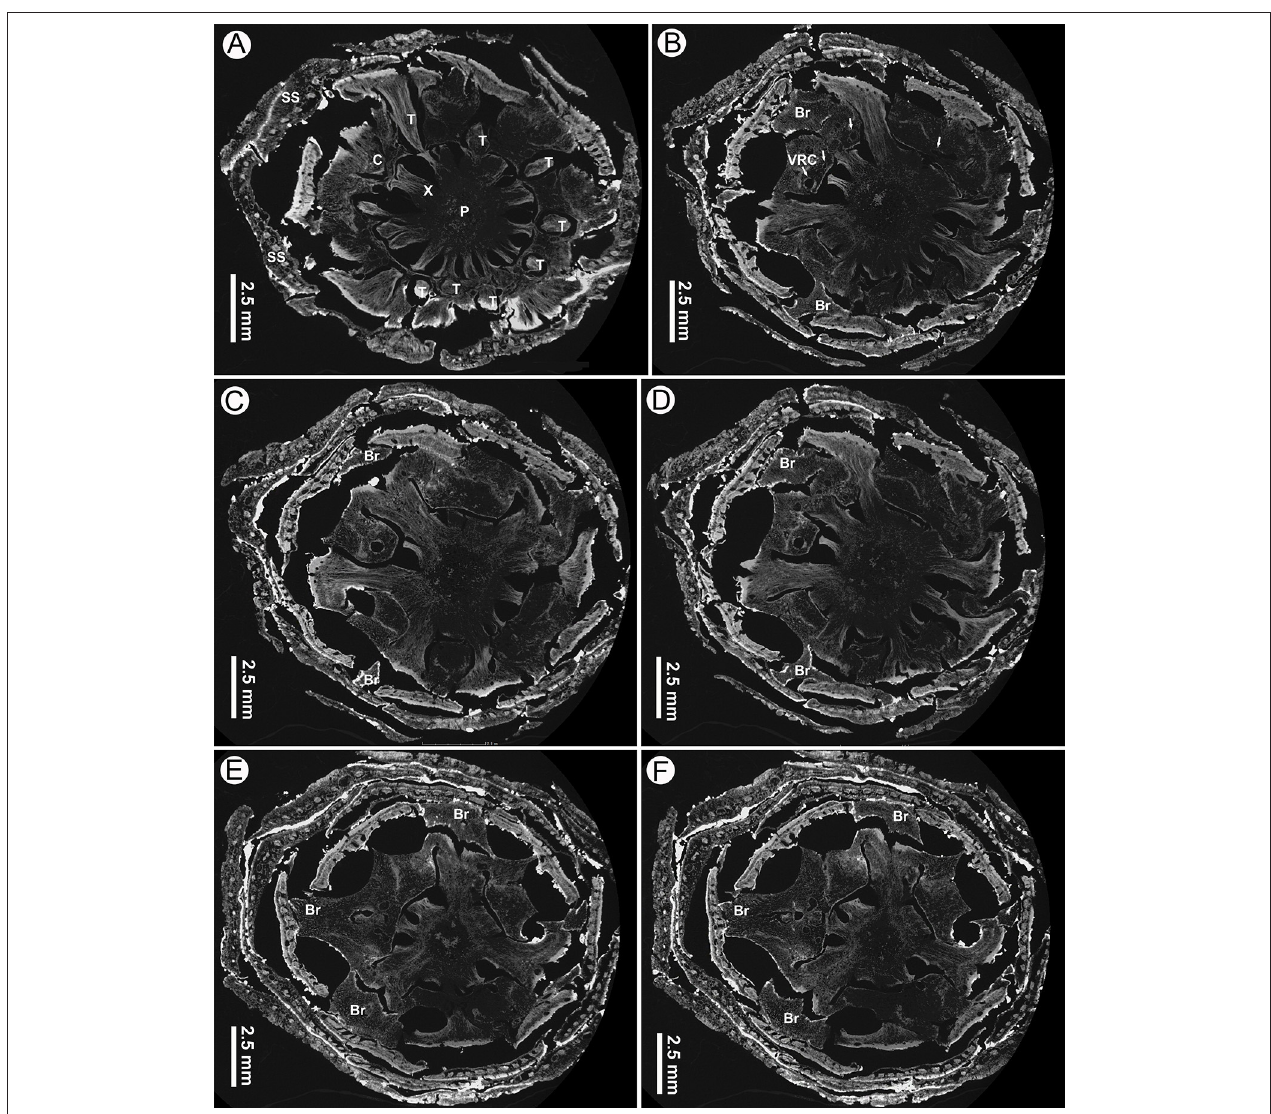
FIGURE 8 | Virtual transverse sections of a seed cone of Pinus prehwangshanensis sp. nov., holotype, specimen MMRH170, micro-CT. (A) Traces of bract-scale vascular complexes (T) diverging from a vascular cylinder of cone axis; note a pith (P), xylem (X), cortex (C), and seed scales (SS). (B) Bracts (Br) separating from a seed scale by a medial pouch and vertical resin canals (VRC, indicated by arrows). (C – F) Bracts (Br) separating from a seed scale by a medial